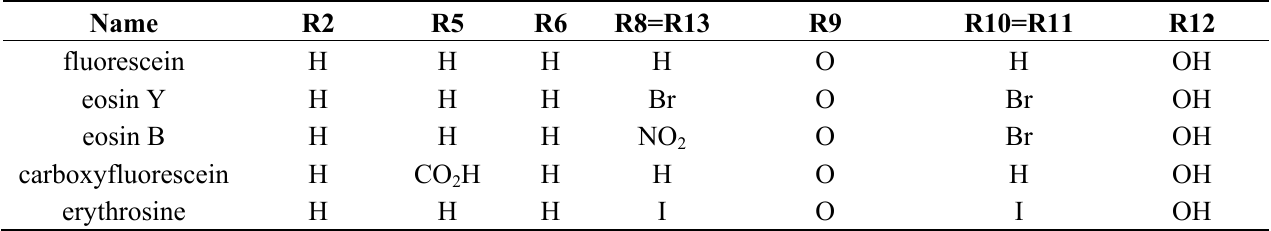
Table 3. R-groups within a series of fluorescein derivatives commonly used clinically in humans. Name